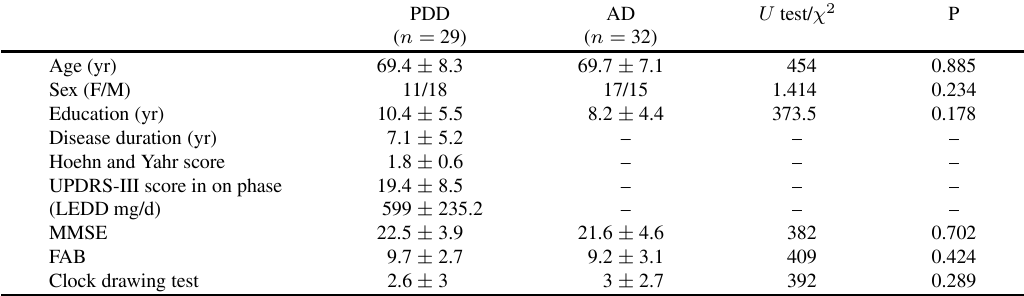
Table 1 Demographic and clinical characteristics of patients with PD-associated Dementia (PDD) and Alzheimer’s disease